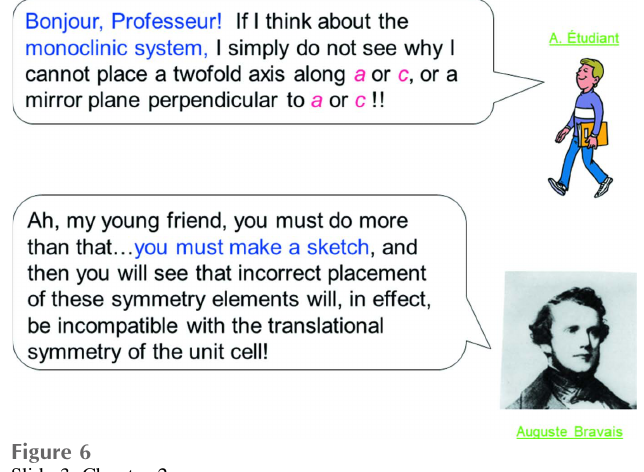
Figure 8 First of two slides illustrating placement of the 2 axis in the monoclinic system (slide 4, Chapter 2).